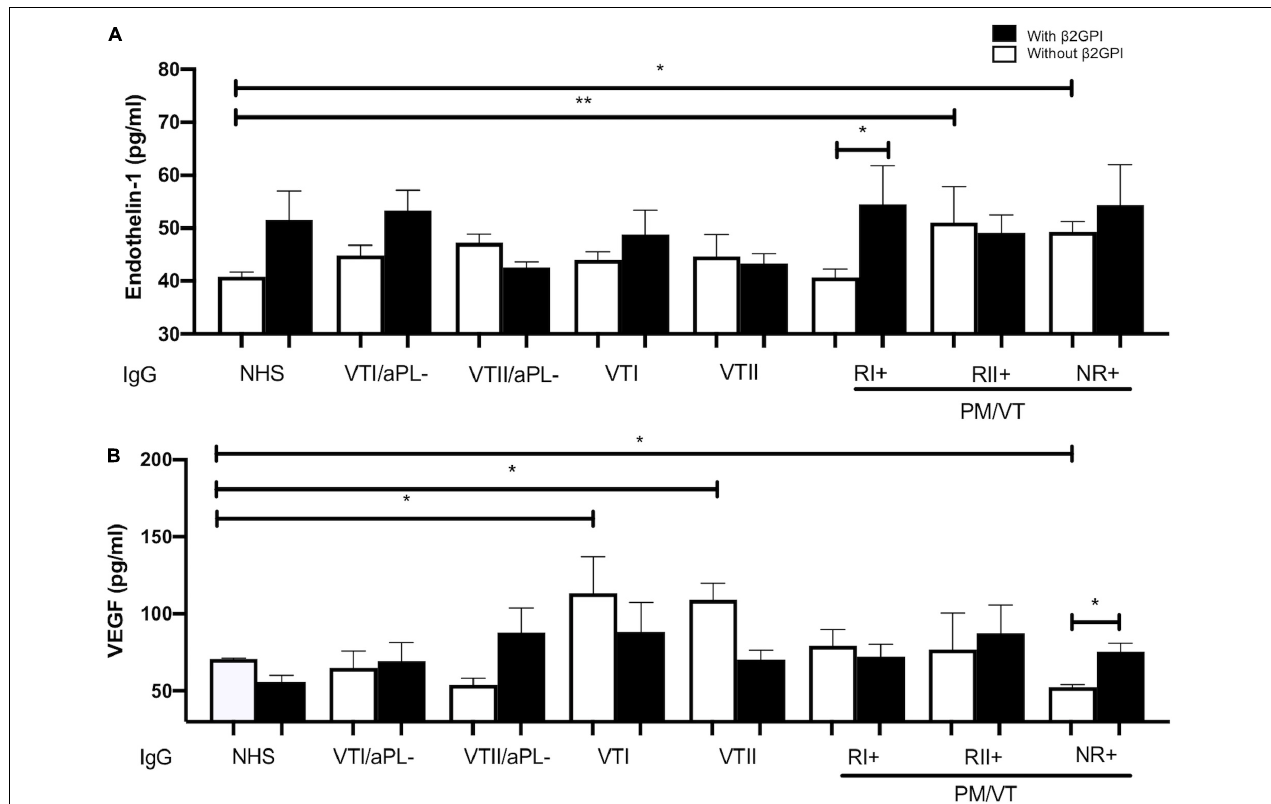
FIGURE 7 | All IgG from patients with APS-induced endothelial dysfunction through an alteration in endothelin-1 or VEGF production in HUVEC supernatants. (A) RII+ and NRI+ IgG groups of patients increased endothelin-1 production compared with IgG/NHS without β 2GPI. RI+ IgG with β 2GPI increased the production of endothelin-1 compared with this same group without β 2GPI. (B) IgG from patients with VTI and VTII increased the VEGF in contrast with NHS IgG without β 2GPI. IgG from patients with NR+ decreased the VEGF amount in contrast with NHS IgG without β 2GPI. NR+ IgG and β 2GPI increased the VEGF production compared with this same IgG without β 2GPI. A two-way ANOVA and the Holm–Sidak post-test (* p < 0.05; ** p < 0.01) were performed. The results were obtained from three independent experiments. PM/VT, pregnancy morbidity and vascular